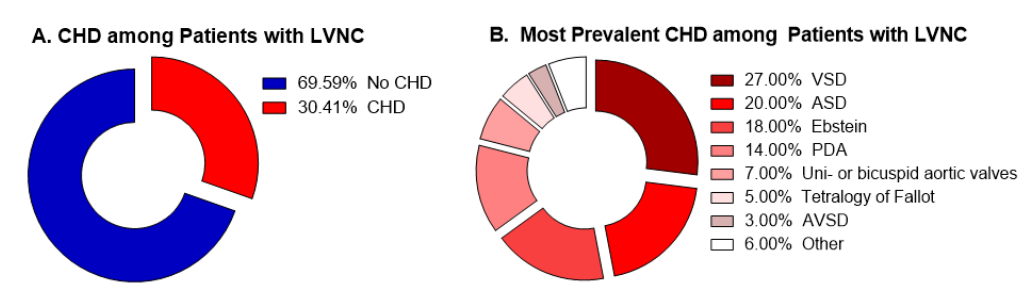
Figure 1. Summary of the current studies available in literature. ( A ) Percentage of patients with CHD among all the patients presenting LVNC. ( B ) Percentage of each CHD among all the patients presenting concomitant CHD/LVNC.